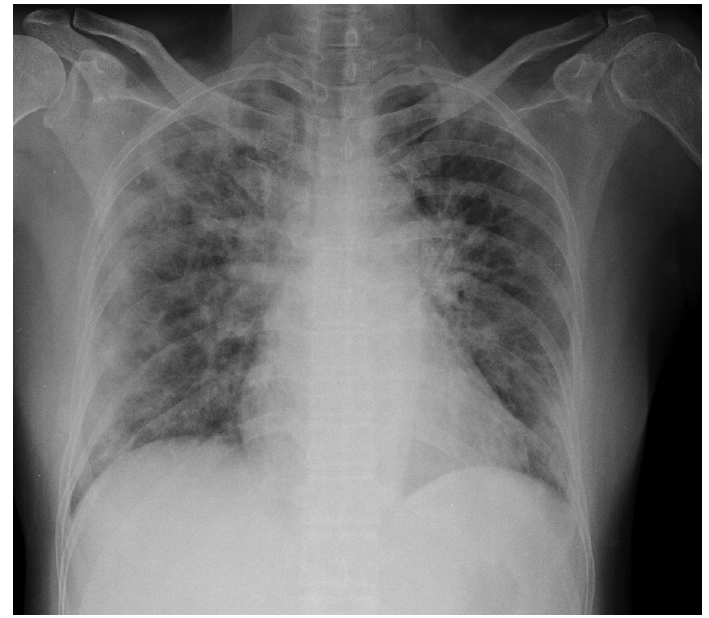
Figure 9. Covid sample: X-ray Image